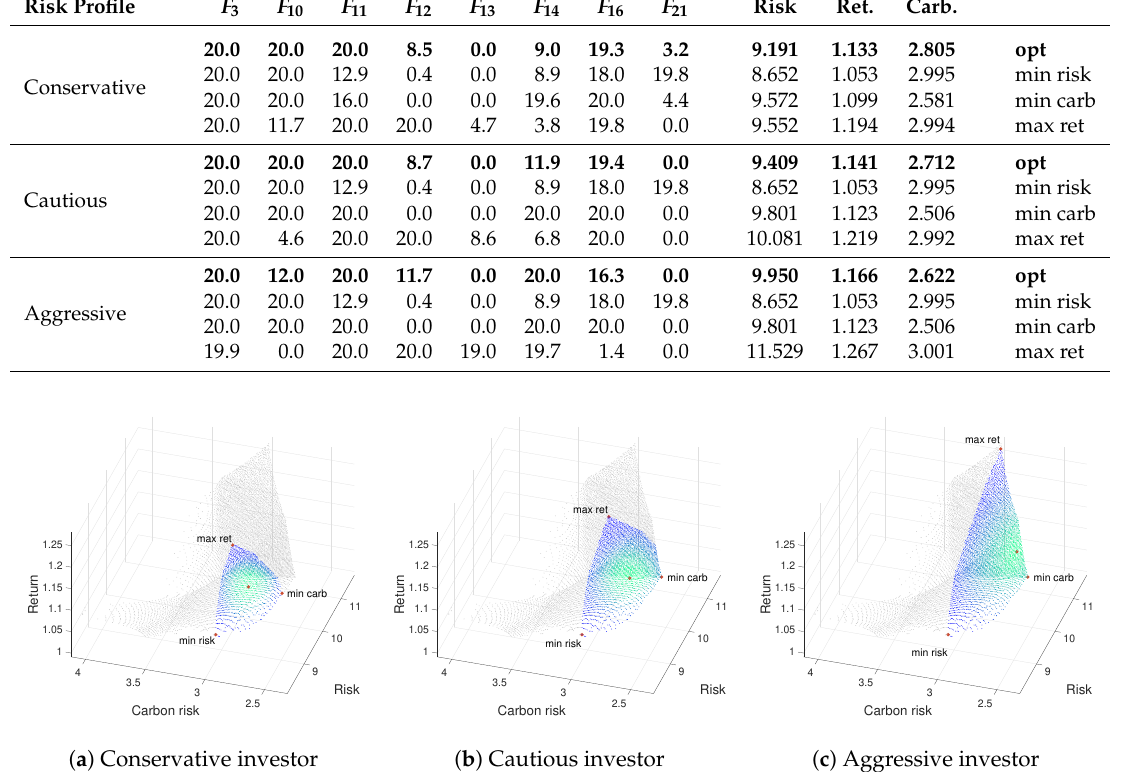
Table 3. Moderate green investor portfolio composition and objective value function.